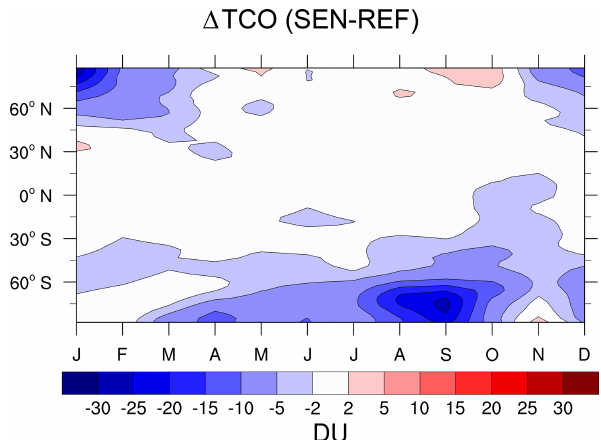
Figure 3. Mean annual cycle of total column ozone (TCO) differ- ences (in Dobson units, DU) between SEN-C2-fCFC11_2050 and REF-C2 for the 2040s (i.e., SEN minus REF).